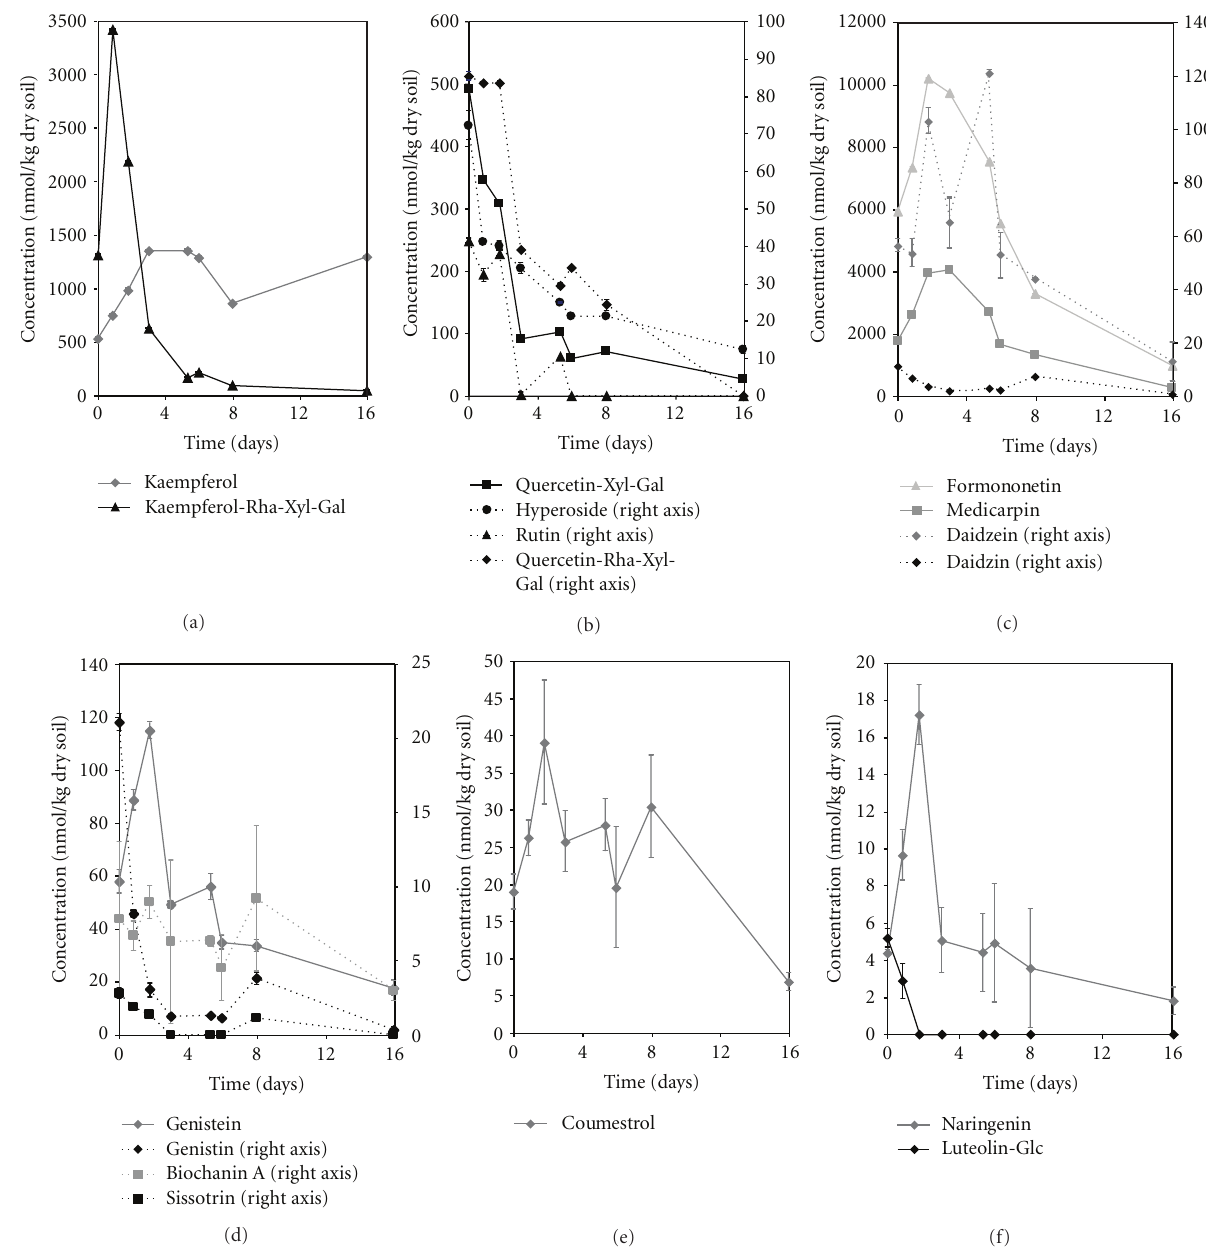
Figure 1: Time profiles of the concentrations of flavonoids leached into clover-amended soil. Error bars indicate 95% confidence intervals.